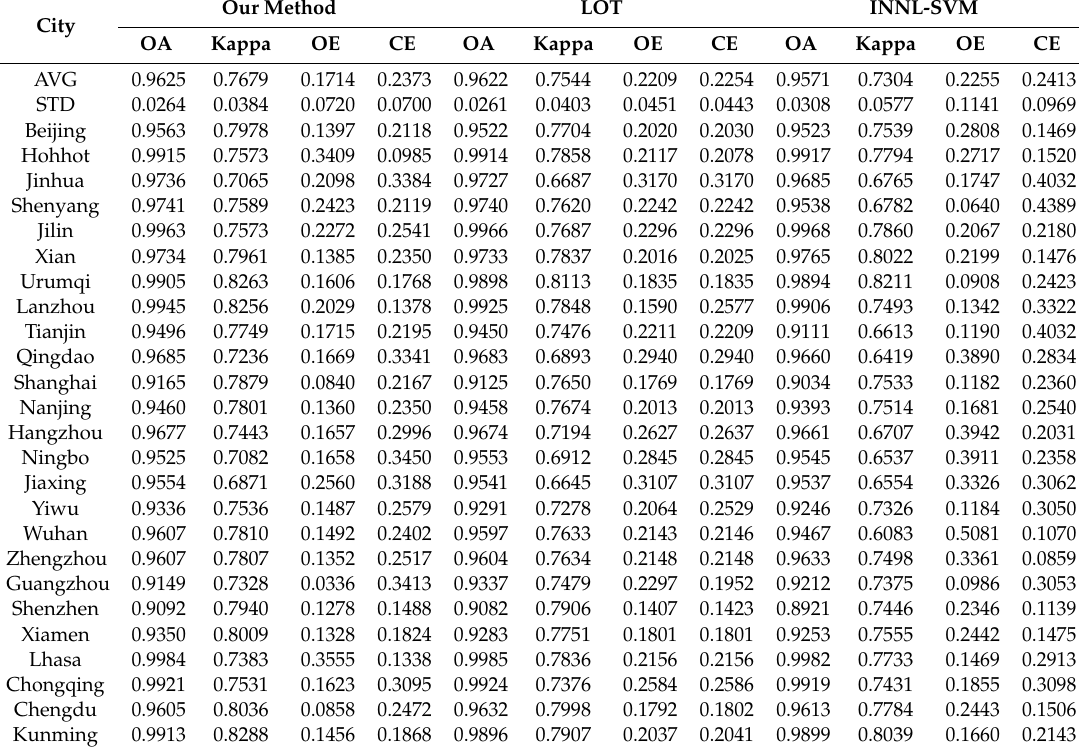
Table 2. Accuracy assessments of the three methods of extracting urban extent by